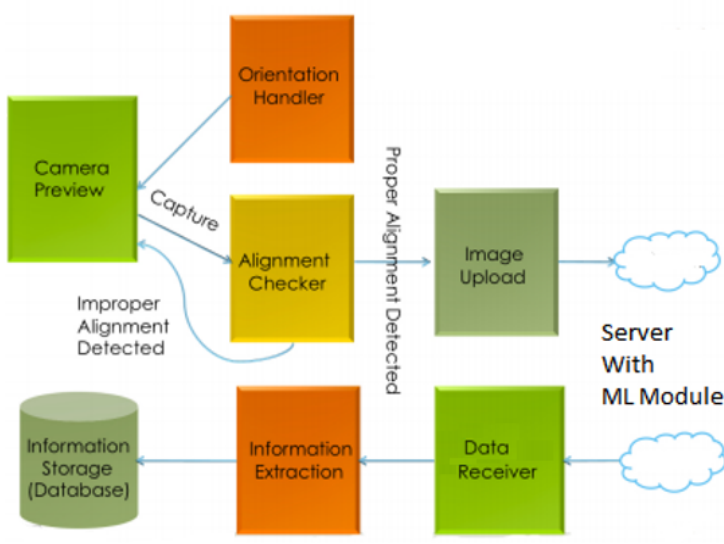
Figure 3. System architecture of the car towing management